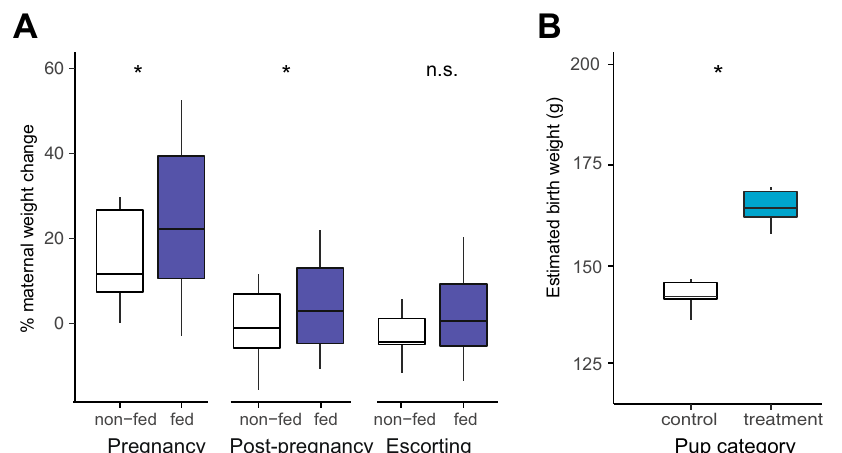
Fig. 2 Effect of gestational feeding on weight of mothers and offspring. A Percent weight change (relative to conception weight) of non-fed (no shading) and fed (dark blue) mothers during pregnancy (5 – 30 days before birth), in the post-pregnancy period (5 – 19 days after birth) and escorting period (30 – 90 days after birth). B Birth weight predicted by our model of pup growth for “ control ” offspring produced by non-fed mothers (no shading) and “ treatment ” offspring produced by fed mothers (light blue) offspring. Filled boxes show the interquartile range (IQR) and median (internal horizontal line). Whiskers (vertical lines) show the extent of observations outside the IQR to a maximum of 1.5x IQR. Other legends: n.s. p > 0.05; * p <